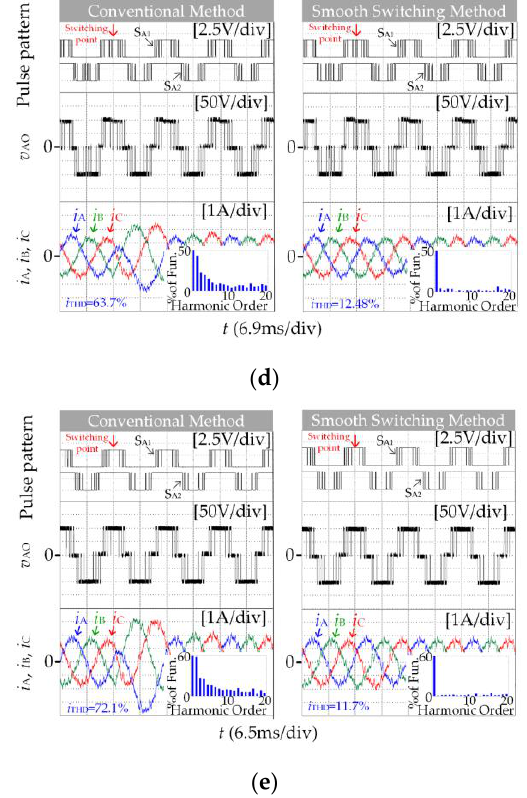
Figure 12. Experimental results of different pulse numbers switching. ( a ) m = 0.6, SSVM_15(I) → SSVM_13. ( b ) m = 0.76, SSVM_13 → SSVM_11(IV). ( c ) m = 0.84, SSVM_11(I) → SSVM_9. ( d ) m = 0.9, SSVM_9 → SSVM_7. ( e ) m = 0.96, SSVM_7 → SSVM_5.